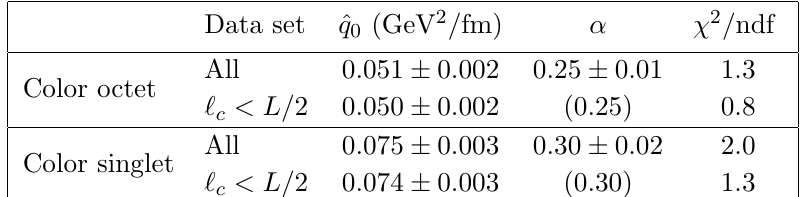
Table 3 . Results of the (cid:12)ts to all and selected ( ‘ c < L= 2) data sets, assuming color octet or color singlet Q (cid:22) Q production.